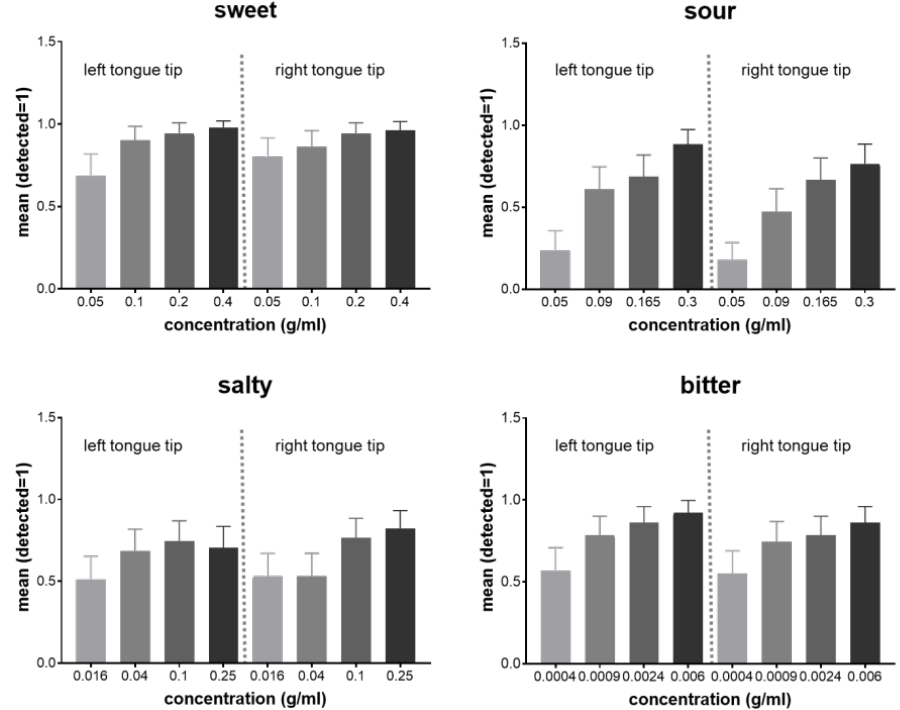
Figure 4. Taste qualities in different concentrations on the left and right tongue side.